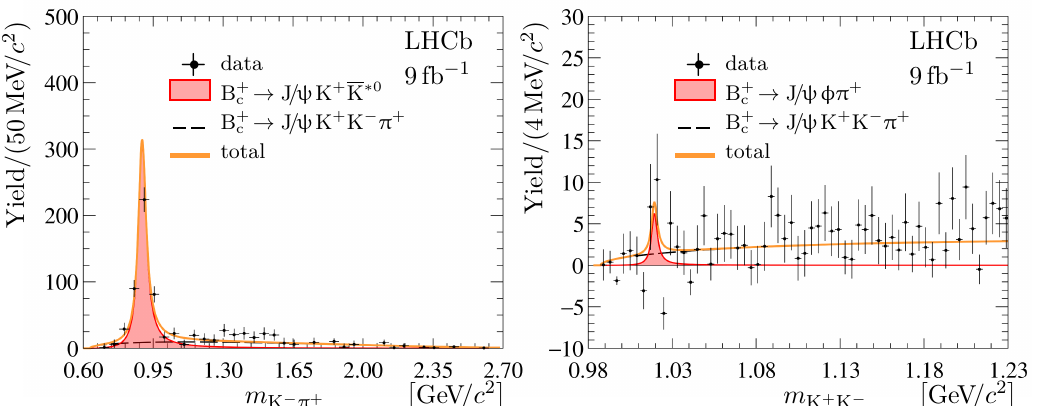
Figure 4 . Background-subtracted (left) K − (cid:25) + and (right) K + K − mass distributions for se- lected B + → J / K + K − (cid:25) + candidates. The K + K − mass spectrum is fitted in the full accessible c K + K − mass region, m < 2 . 923 GeV/ c 2 . For better visibility, only a low-mass part of the spec- K + K − trum is